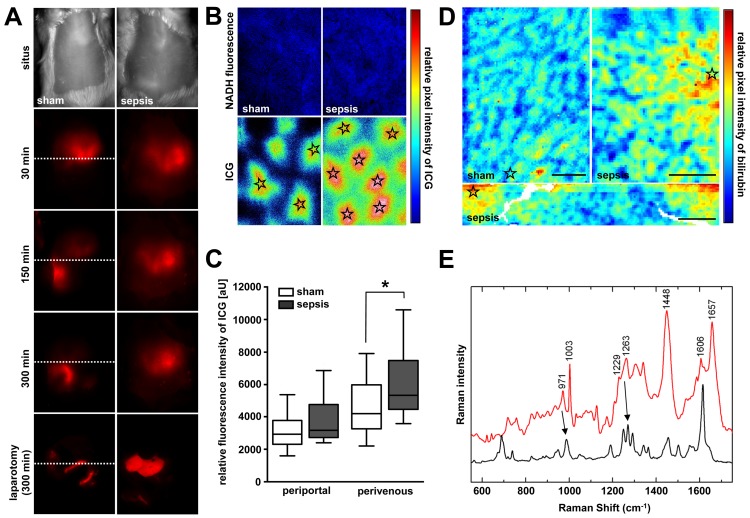
Sepsis-induced excretory dysfunction, as visualised by accumulation of the xenobiotic indocyanine green and bilirubin.(A) Non-invasive whole body near-infrared fluorescence imaging of ICG at 15 h after sepsis induction. Shown are representative images from sham-treated animals (left panels) and animals subjected to lethal sepsis (right panels) for five biological replicates each. While ICG is eliminated via hepatobiliary excretion into the duodenum within the 300-min observation period in sham animals, the dye accumulates in the livers of septic animals, with an almost absence of fluorescence signal in the gut, as confirmed after laparotomy (lower panels). The dotted line divides upper and lower abdominal quadrants for orientation. (B) Subsequent epifluorescence microscopic examination of liver surfaces at 300 min after ICG administration in sham and septic animals. Stars indicate central veins (magnification 50×, pseudo-coloured). (C) ICG fluorescence intensities around central veins were significantly higher in septic compared to sham-operated animals (n = 4 animals/group, five perivenous and five periportal areas per animal, *p = 0.031 compared to sham). (D) Representative micro-Raman images of tissue sections from liver sections obtained from sham-operated and septic rats 15 h post-insult. In the livers of the septic rats, relative intensities of the bilirubin component are elevated in the perivenous region (stars). In contrast, only minor local spots of accumulated bilirubin could be verified in livers of control animals. Scale bars: 50 µm. (E) Raman spectrum of the bilirubin component (red trace) with crystalline bilirubin for comparison (black trace). Main spectral contributions of bilirubin are resolved near 971, 1,229, and 1,606 cm−1 (arrows at 971 and 1,229 cm−1; high peak at 1,606 cm−1).